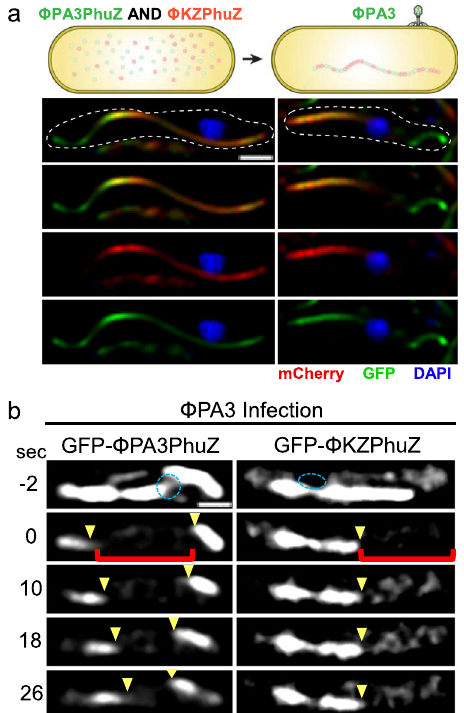
Fig. 3 Nonfunctional hybrid spindles form through cross-species mixing of PhuZ monomers. a Simultaneous expression of sfGFP- Φ PA3PhuZ (green) and mCherry- Φ KZPhuZ (red) results in hybrid fi laments (yellow) and mispositioning of the Φ PA3 nucleus (blue). b Photobleaching of sfGFP- Φ PA3PhuZ (left) shows movement of bleached zones indicating treadmilling (yellow arrows) during Φ PA3 infection. Photobleaching of hybrid spindles formed by expressing sfGFP- Φ KZPhuZ and cross infecting with Φ PA3 demonstrates fi laments are not dynamic. Scale bars equal 1 μ